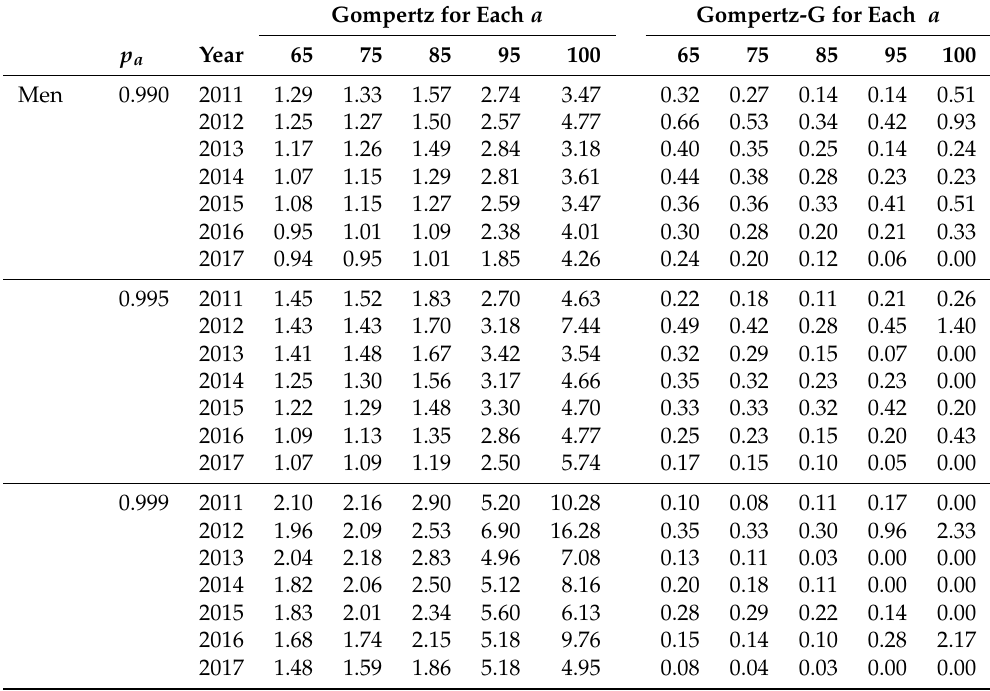
Table A5. Quotients between empirical and theoretical ( 1 − p a ) significance levels of estimated CQ p for the age-at-death of the population aged over 65 in Spain separately for men and women, from 2011 to 2017, using Gompertz and Gompertz-G